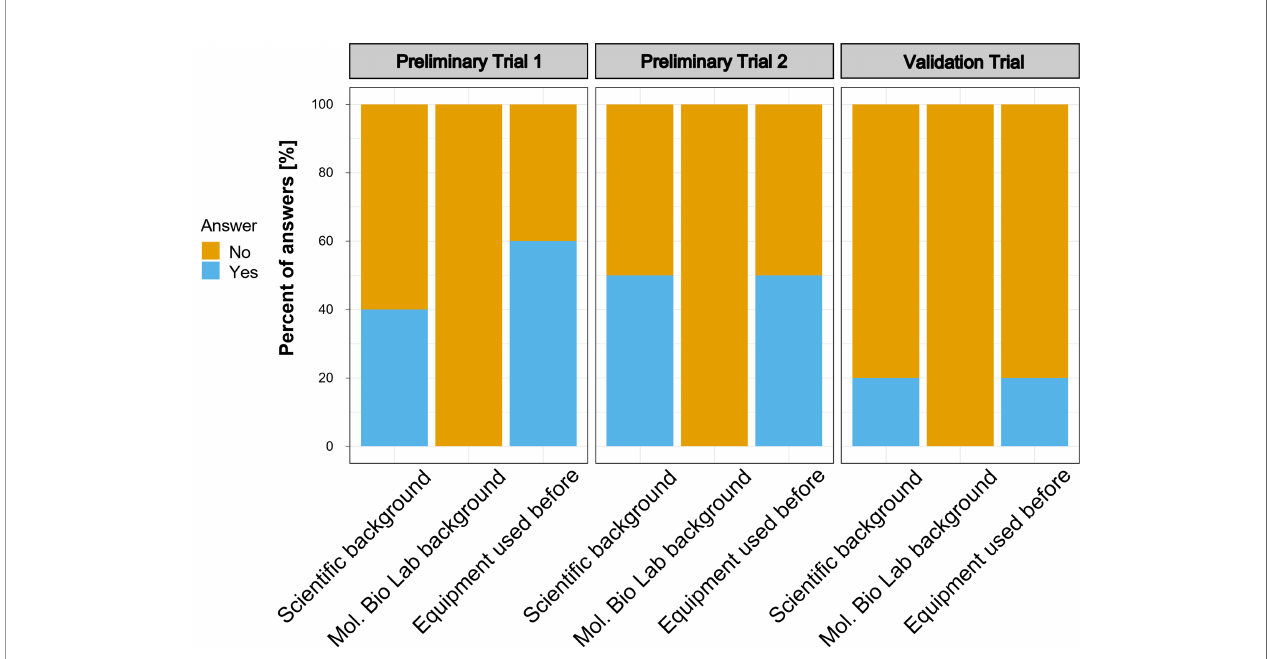
FIGURE 6 | Background of the participants of the trial studies. Number of participants in the trials were as follows: Preliminary Trial 1 – n=4; Preliminary Trial 2 – n = 5; Validation Trial – n=10.